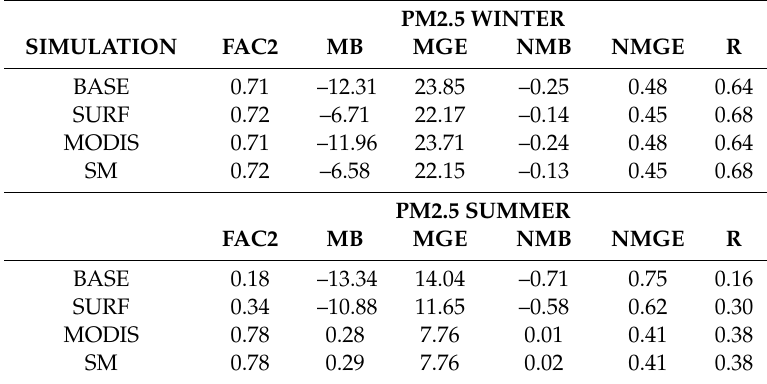
Table 3. Mean statistics based on hourly PM2.5 observations for the winter and summer episodes over Poland. Units for MB and MGE are µ g m − 3 ; other statistics are dimensionless. p -Value < 2.2 × 10 –16 for